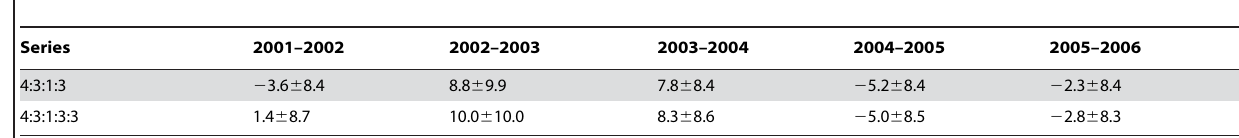
Table 2. Statistical comparisons of observed differences (%) in annual coverage levels by vaccine series.